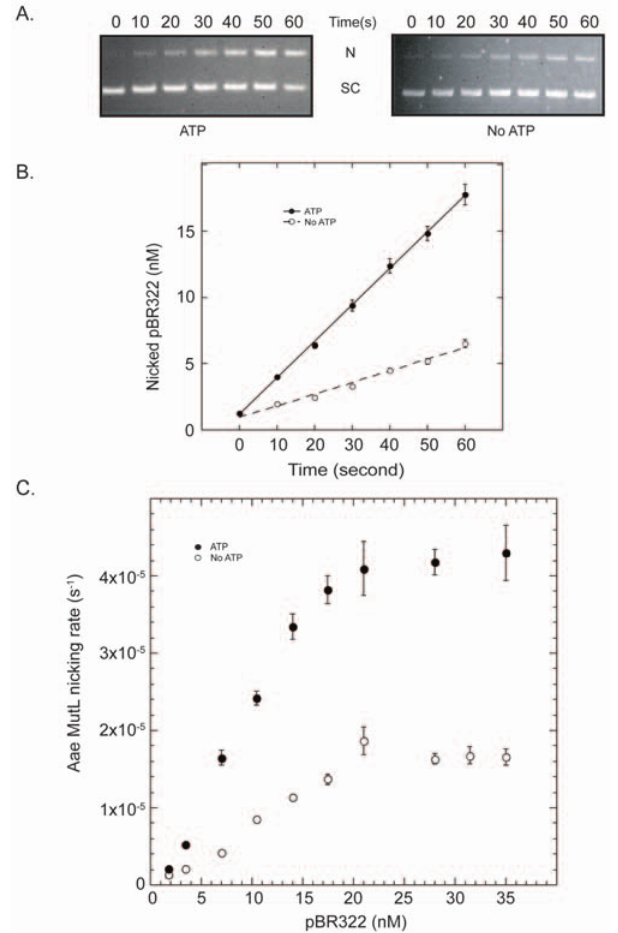
Figure 2. ATP effect on the rate of MutL nicking activity. Reaction time courses of Aae MutL (6.4 m M) with different concentra- tions of supercoiled pBR322 plasmid. A, Representative data of MutL induced pBR322 (35 nM) nicking time courses with (left hand panel) or without (right hand panel) ATP. An aliquot of the reaction was removed and quenched every 10 seconds as described in the Materials and Methods. B, Bands from the agarose gel time courses were quantified using ImageJ software and the concentration of nicked plasmid was plotted against time. The nicking time courses were generated in the presence (solid circles) and absence (open circles) of ATP. C, The initial nicking rates of Aae MutL were plotted against the concentration of pBR322 used during the time course. The MutL nicking activity was measured with (solid circles) or without (open circles) ATP. Individual points represent the average of 3 separate experiments. Error bars that are not visible are covered by the point marker.